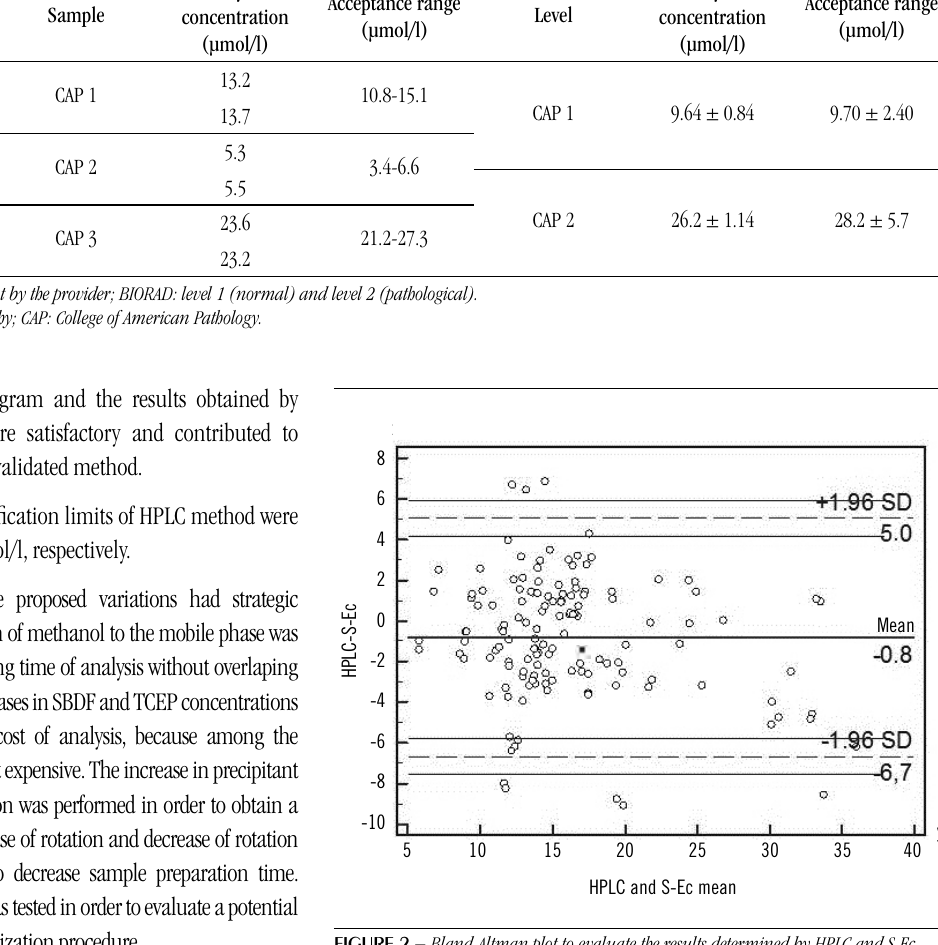
figurE 2 − Bland-Altman plot to evaluate the results determined by HPLC and S-Ec X-axis represents the concentration means obtained in the replicates of both techniques, and Y-axis represents the concentration difference obtained between HPLC and S-Ec results. HPLC: high-performance liquid chromatography; S-Ec: spectrophotometric enzymatic cycling; SD: standard deviation represented by the dashed line; Mean: mean represented by the solid line.